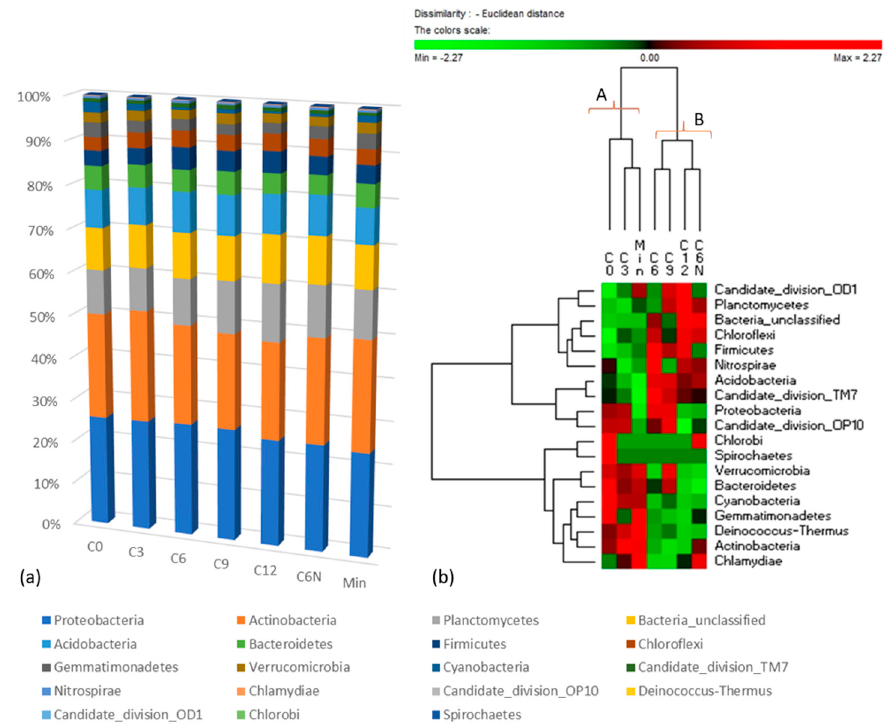
Figure 5. Bacterial composition of the soil samples. ( a ) Relative abundance of phyla associated to soil samples; ( b ) Heatmap showing bacterial diversity (at phylum level) across the different soil managements. C0, unfertilized soil; C3, C6, C9 and C12 = 3, 6, 9 and 12 Mg/ha sewage sludge compost, respectively; C6N, combined application of 6 Mg/ha of sewage sludge and 60 kg/ha N; Min, mineral fertilization.